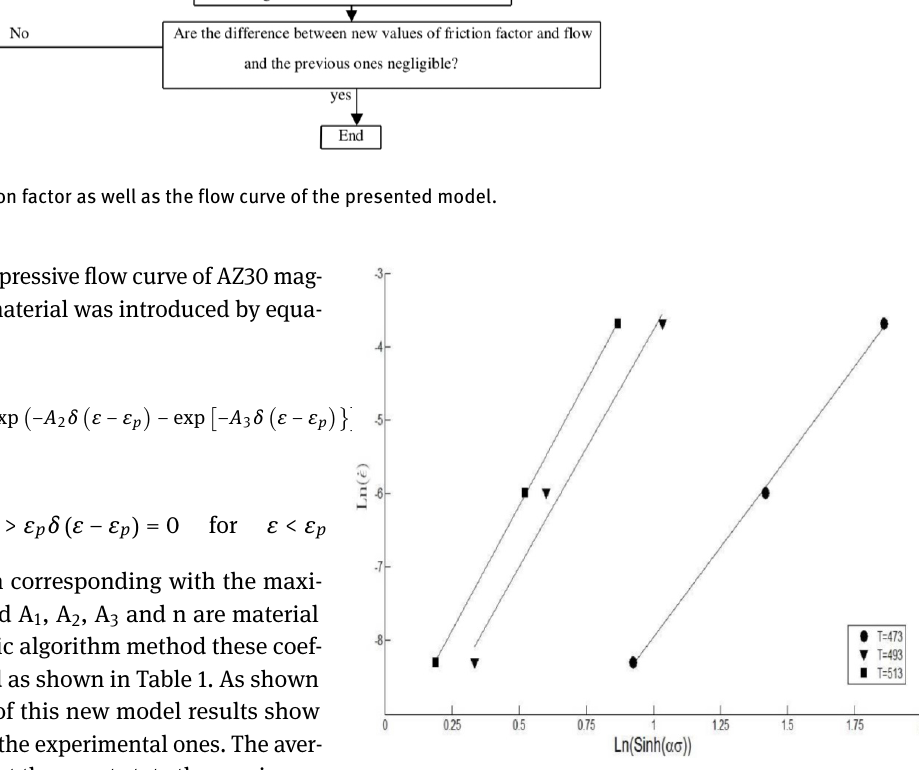
Figure 6: Plotting Ln(sinh( ασ )) versus Ln (˙ ε ) at constant temperature and different strain rates condition at the maximum amount of strain related to